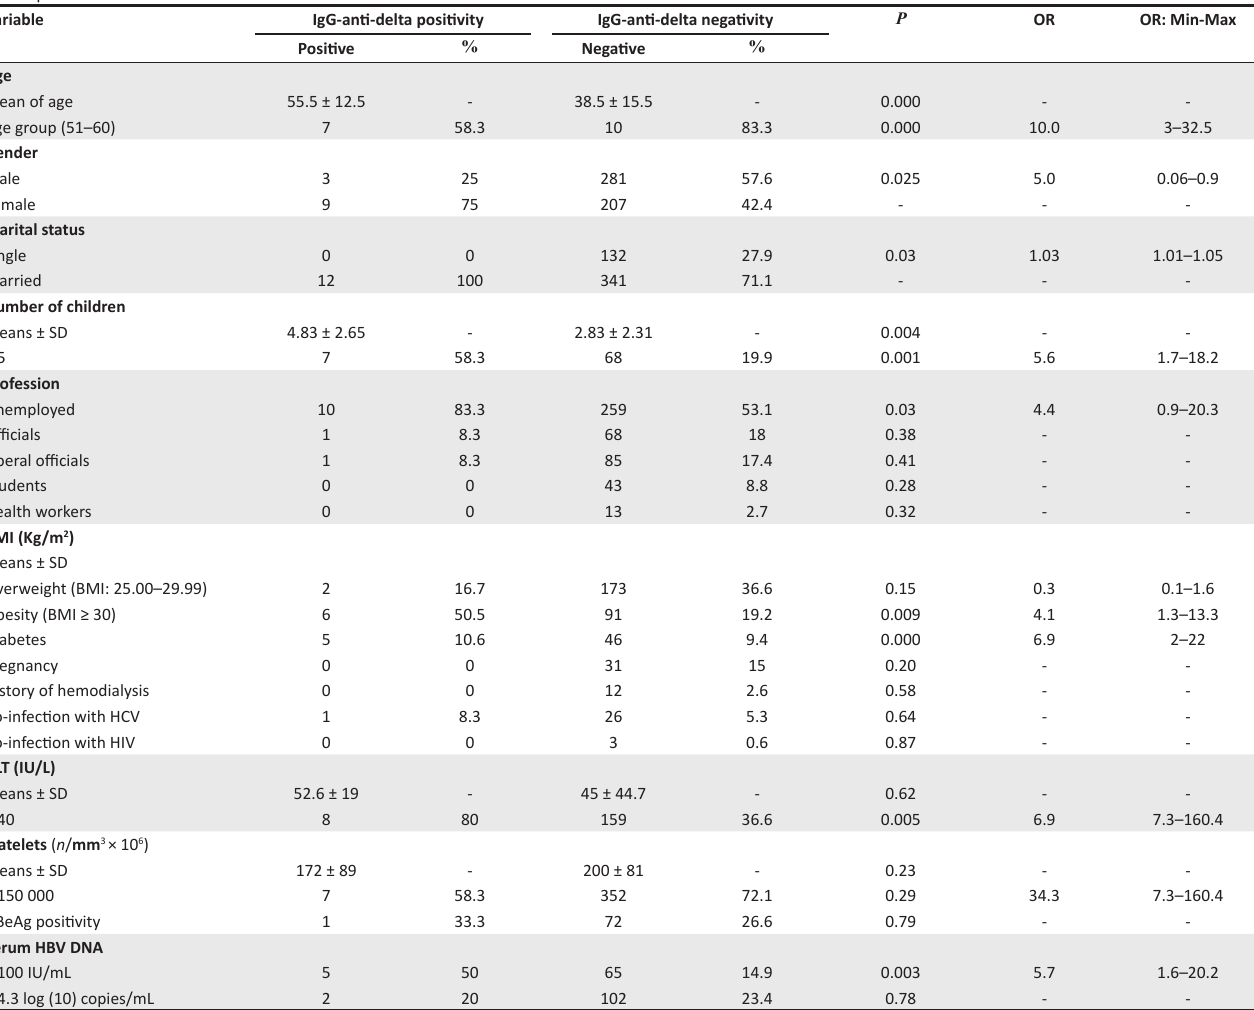
TABLE 1: Relationship with demographic characteristics, diabetes, pregnancy, history of hemodialysis, co-infection with HCV or HIV, biological and virological parameters and hepatitis delta virus.